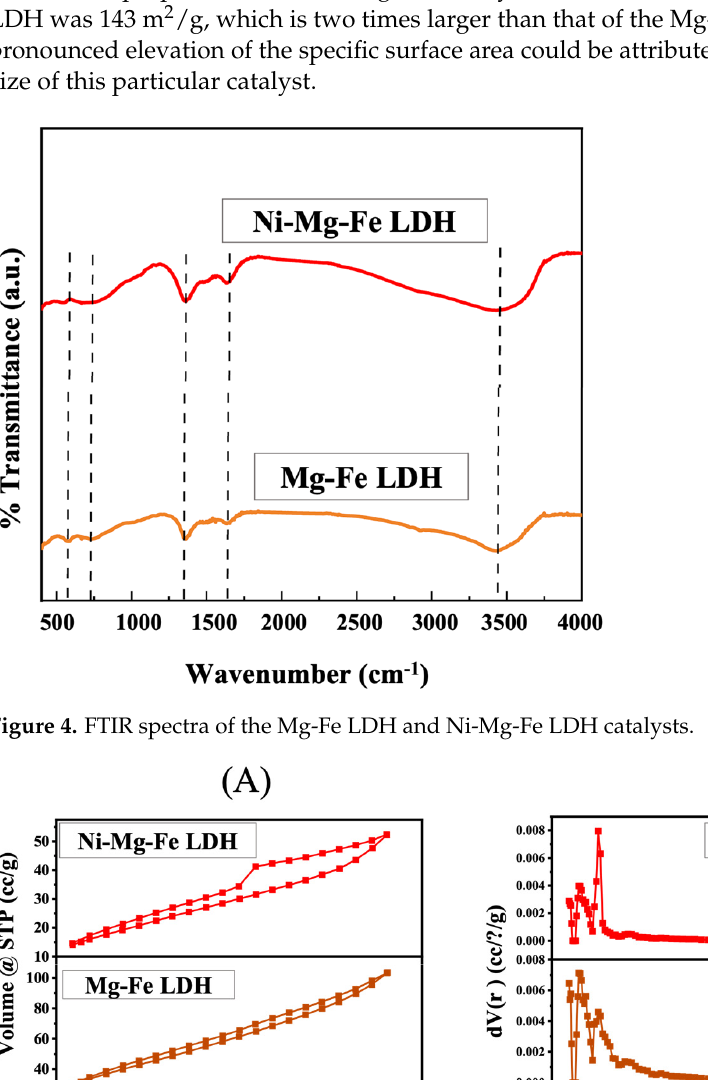
Figure 5. ( A ) N 2 adsorption–desorption isotherms; ( B ) pore size distribution curves for the Mg-Fe LDH and Ni-Mg-Fe LDH catalysts. Table 1. Textural properties of the different catalysts from N 2 - physisorption. Sample